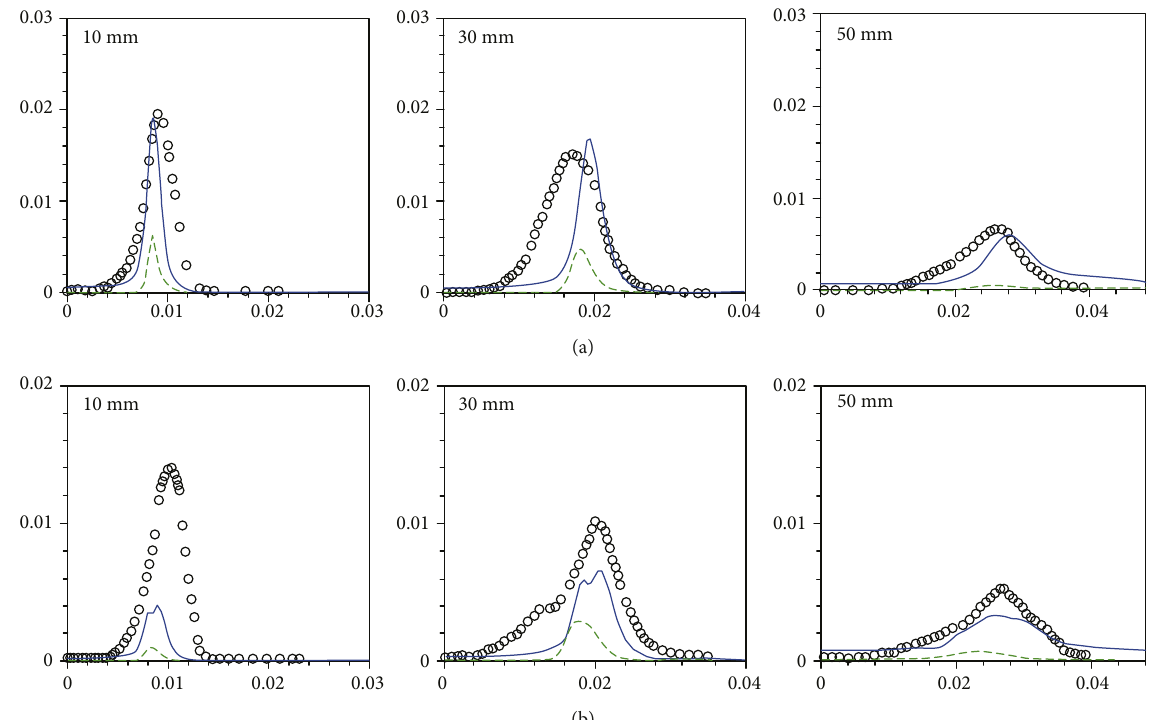
Figure 12: Comparison of mean (a) and rms (b) CO mass fraction at Δ X = 10mm , 30mm, and 50mm (circles, experimental results; dash line, Mech I simulation; solid line, Mech II simulation).